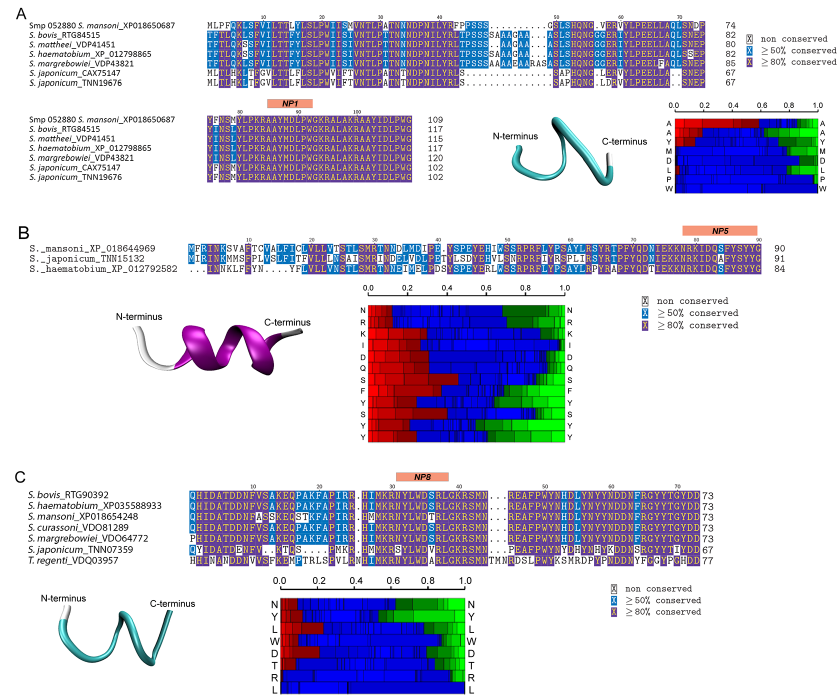
Figure 6. Structure of bioactive peptides and comparative multiple sequence analyses of their respective precursor proteins, including information on conserved amino acids. ( A ) Sm-npp-5 and NP1 (AAYMDLPW-NH 2 ); ( B ) Sm-npp-33 and NP5 (NRKIDQSFYSYY-NH 2 ); and ( C ) Sm-npp-17 and NP8 (NYLWDTRL-NH 2 ). Structural alphabet (SA) (vertical axis) at each position. Colour code: red: helical, green: extended, blue: coil. Heatmaps and structural models were generated using PEP-FOLD3 and visualised using VMD 1.9.3.